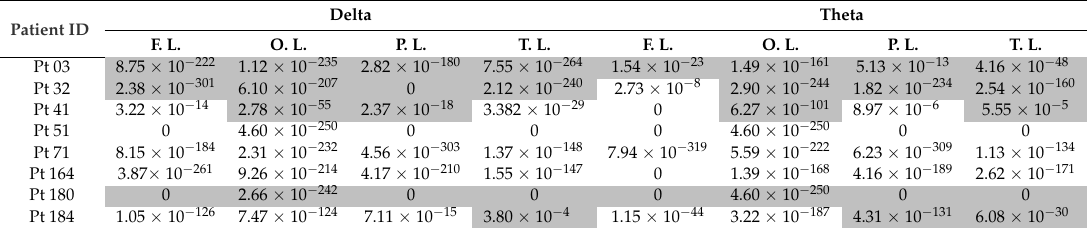
Table A1. p -values resulting from the Wilcoxon rank sum test for delta and theta